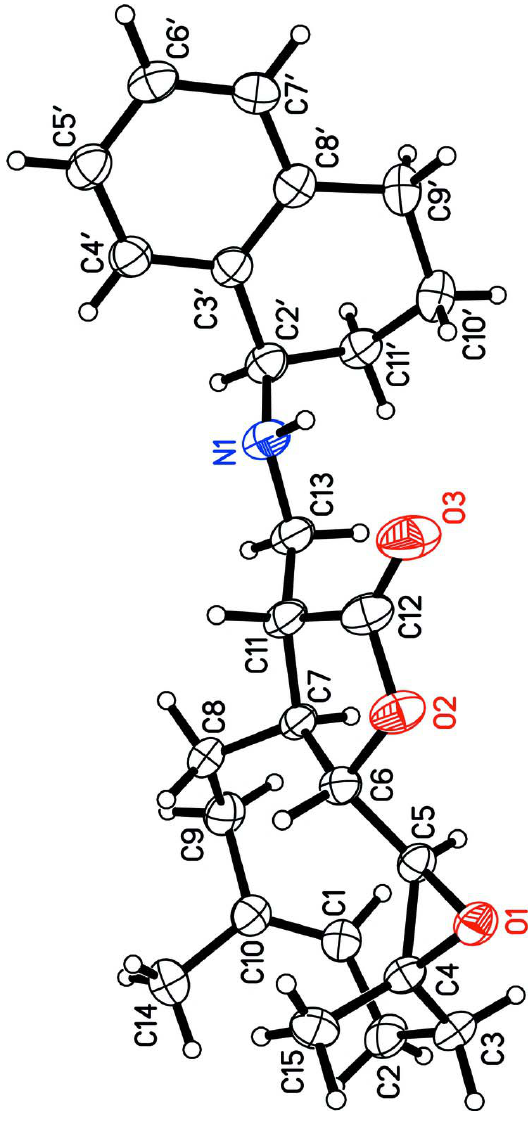
A view of the asymmetric unit of the title compound with displacement ellipsoids drawn at the 50% probability level; H atoms are shown as small spheres of arbitrary